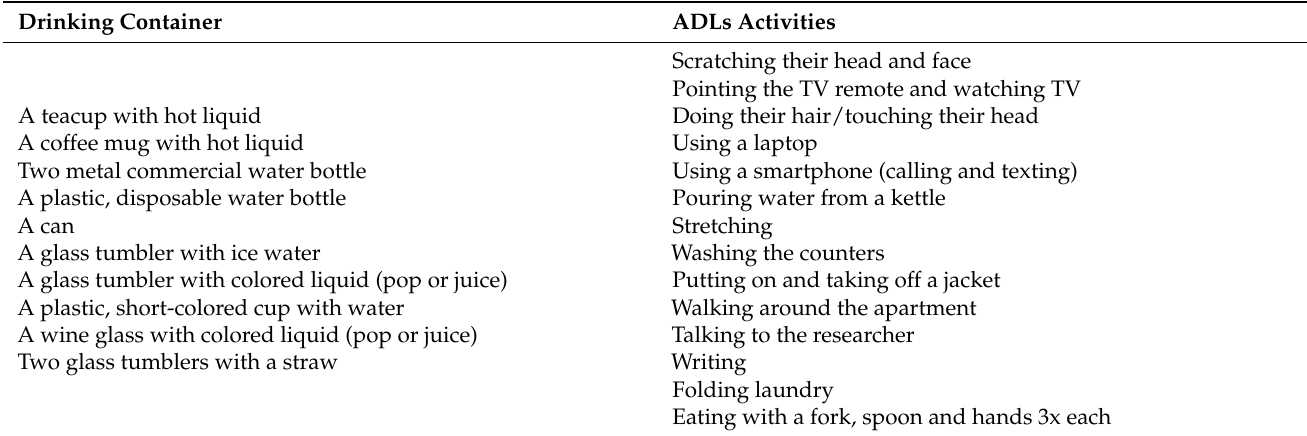
Table 1. List of all activities performed in our study.